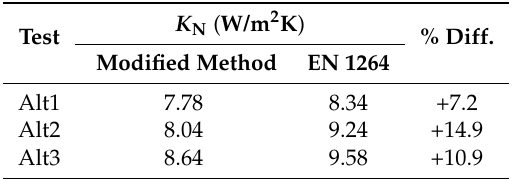
Table 5. Gradient of the characteristic curve calculated via the two